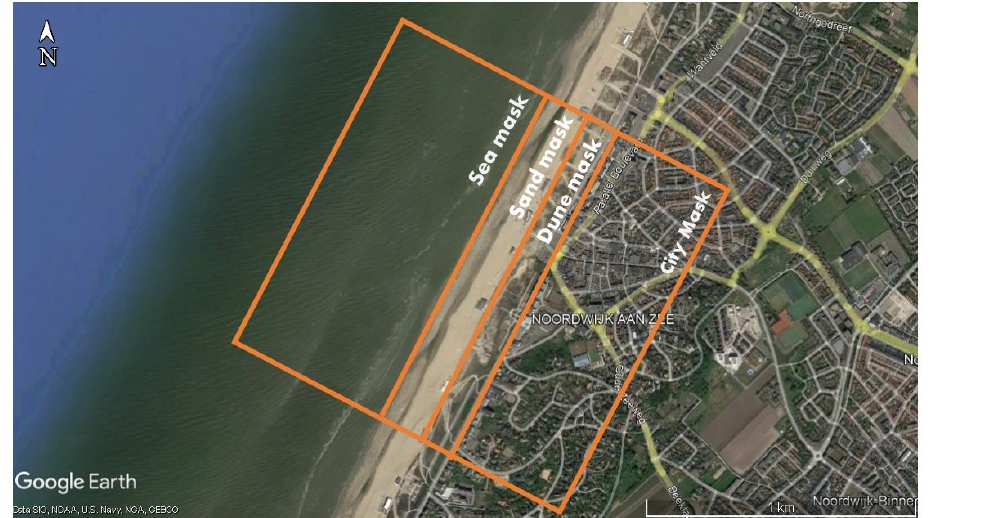
Figure 3. Masks selected on the study area (background image from Google Earth